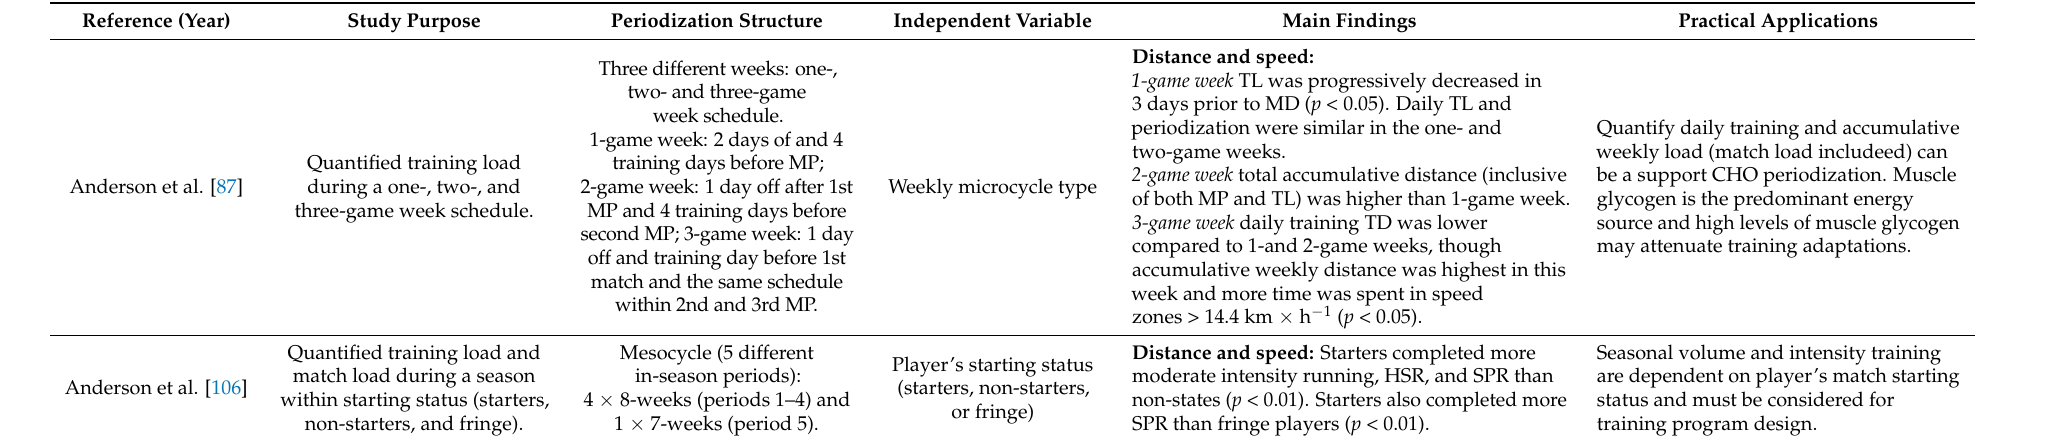
Table 6. Studies with predominant focus on weekly training load and match load distribution